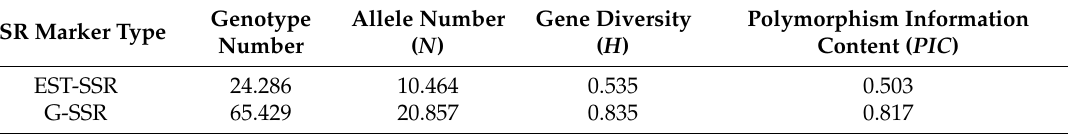
Table 2. Diversity of EST-SSRs and G-SSRs in Robinia pseudoacacia